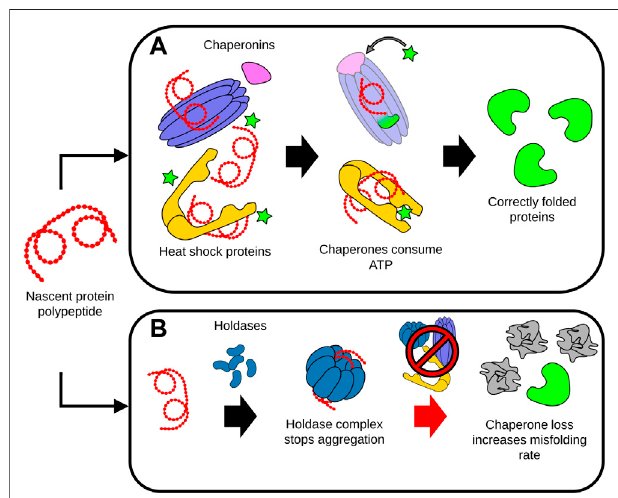
FIGURE 3 | Dysregulation of protein folding during aging. (A) Chaperones assist the proper folding, refolding and disaggregation of proteins. ATP-dependent chaperones such as chaperonins and heat shock proteins interact with protein polypeptides to stabilize folding intermediates. The energy provided by ATP enables the conformational support and subsequent release of the folded protein by the chaperone complexes. (B) Unfolded proteins or polypeptides can be sequestered by holdases. Holdase proteins assemble into higher-order complexes, capable of isolating and preventing the aggregation of the disordered unfolded proteins and peptides. During aging, de fi cits in chaperone levels and activity signi fi cantly increases the rate of protein misfolding, accelerating the accumulation of damaged, misfolded and aggregated proteins This accumulation of misfolded proteins can in turn overwhelm the capacity of the remaining chaperones to maintain proteostasis, leading to cell malfunction and